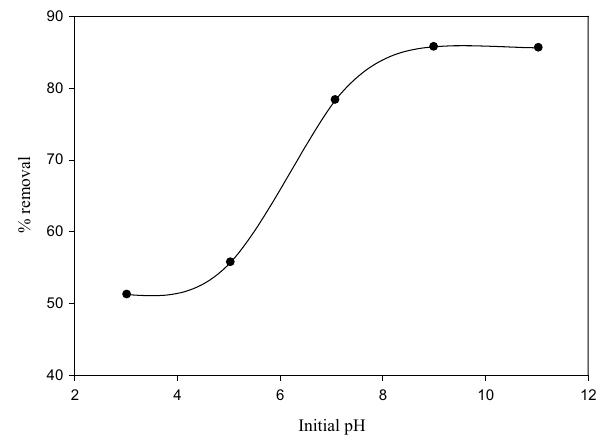
Fig. 2 Plot of percentage removal against initial pH for adsorption of aqueous methylene blue solution on coconut coir dust at 30 °C